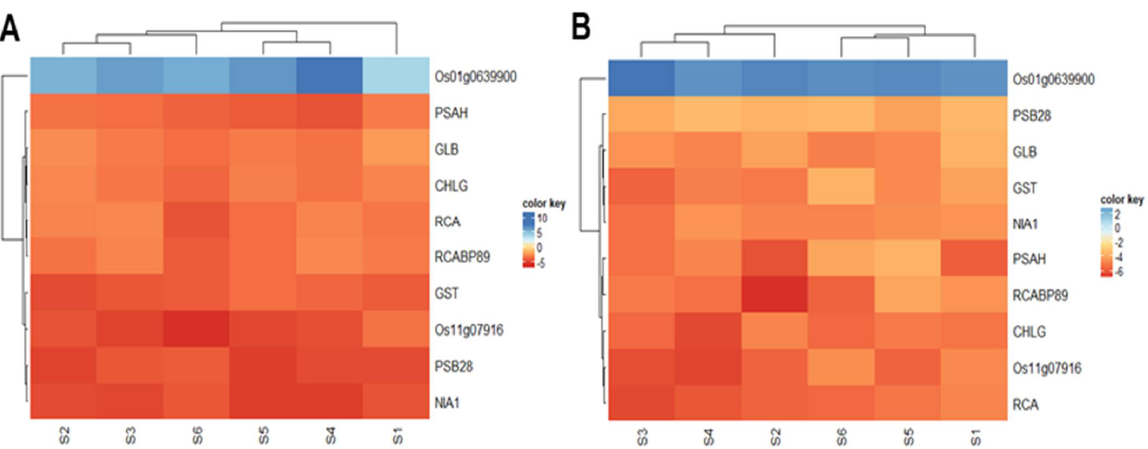
Figure 7. Heatmaps represent the gene expression qRT–PCR by cultivar Panvel ( A ) and Nagina 22 ( B ) under low–N supply. The relative expression was evaluated with the comparative cycle threshold method taking Actin–1 as the reference gene. The relative expression levels were calculated and normalized concerning Actin-1 mRNA (S1–3rd tiller, S2–6th tiller, S3–flag leaf, S4–booting, S5–panicle, and S6–milk stages).